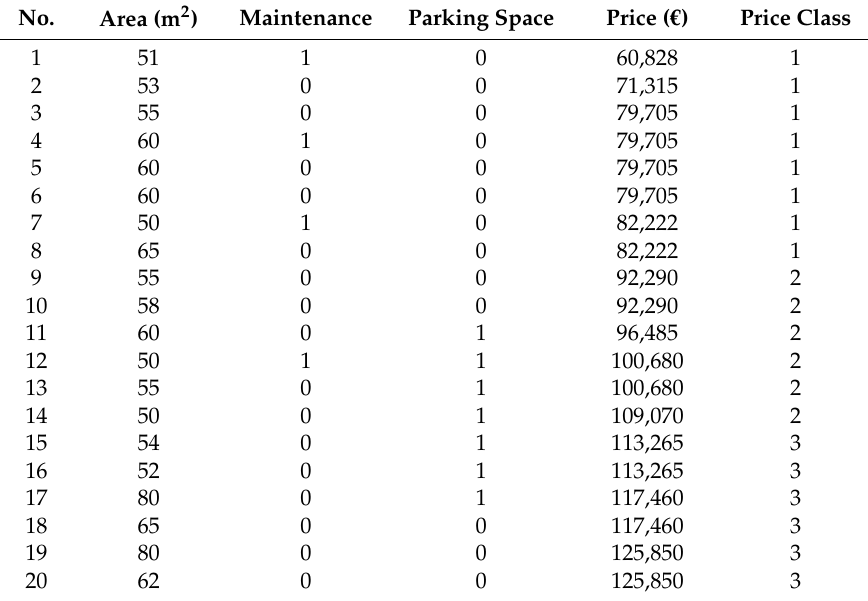
Table 1. Real estate